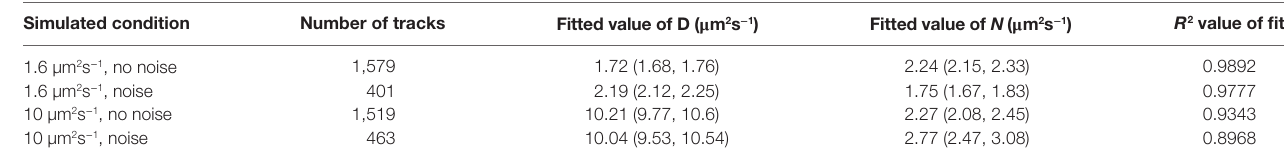
TaBle 1 | Results of one-gamma distribution fitting to simulated single diffusion coefficient distributions.